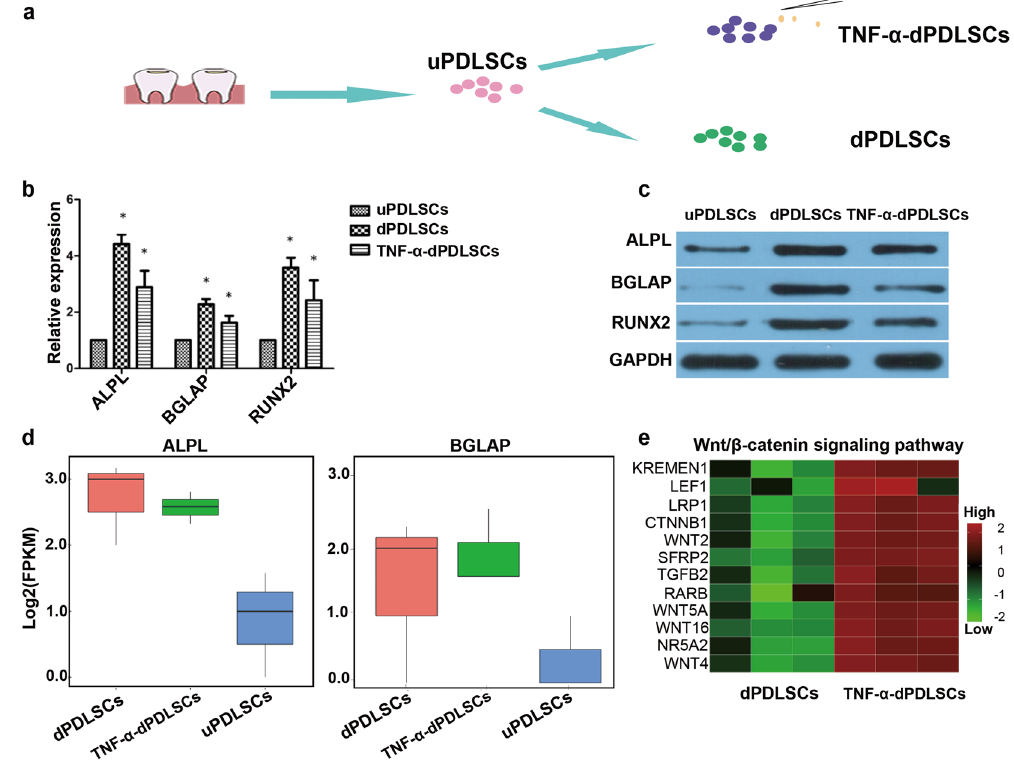
Figure 1. The osteogenic differentiation was suppressed by an inflammatory microenvironment. ( a ) The PDLSC subsets used for RNA sequencing analysis. The cells were isolated from the middle part of the root surface from premolar teeth and cultured for approximately 3-4 generations until the cells exhibited stem cell characteristics (uPDLSCs). With or without induction of TNF- α for 7 days, uPDLSCs were subcultured into dPDLSCs and TNF- α -dPDLSCs. ( b ) The expression of the osteogenic differentiation markers ALPL, BGLAP and RUNX2 in uPDLSCs, dPDLSCs and TNF- α -dPDLSCs was determined by quantitative RT-PCR. ( c ) The expression of the osteogenic differentiation markers ALPL, BGLAP and RUNX2 in uPDLSCs, dPDLSCs and TNF- α -dPDLSCs was determined by western blot. ( d ) The expression of the osteogenic differentiation markers ALPL and BGLAP was determined by RNA-Seq. ( e ) Heatmap showing the expression of genes involved in the Wnt/ β -catenin signaling pathway that were significantly upregulated in TNF- α -dPDLSCs compared to